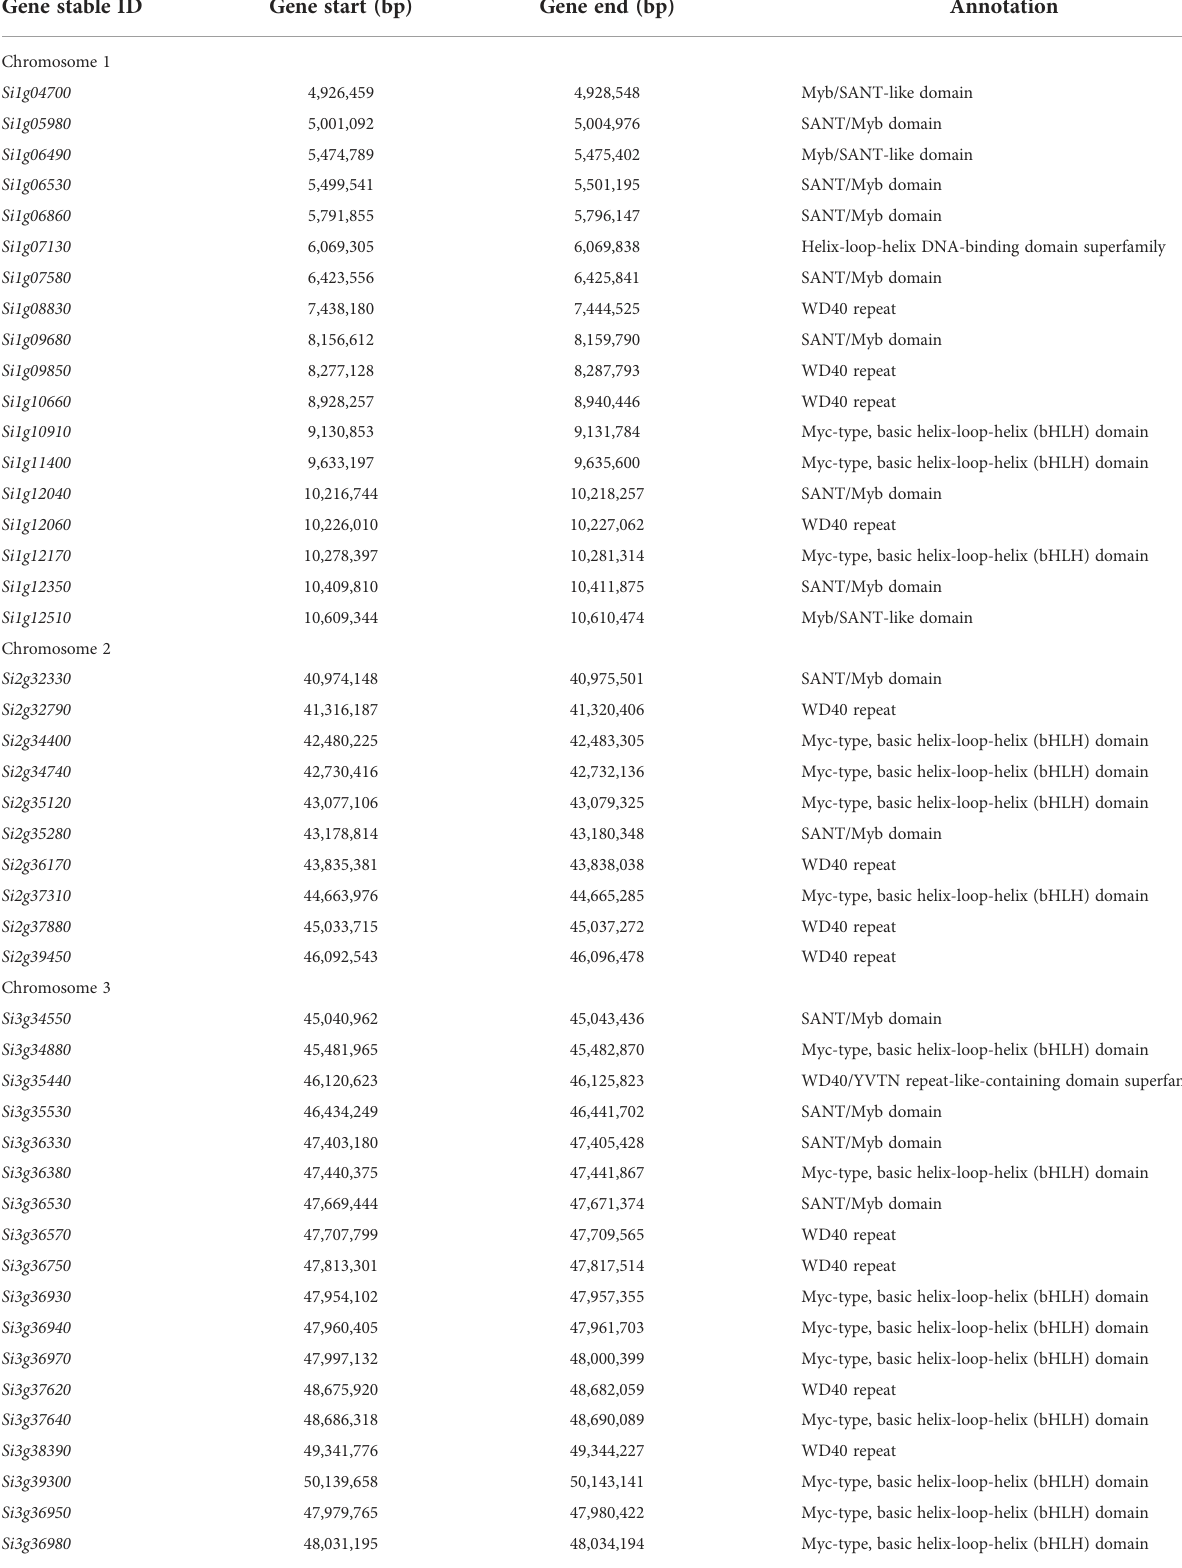
TABLE 3 Annotated genes in the genomic regions associated with hull color identi fi ed by the BSR-Seq analysis. Gene stable